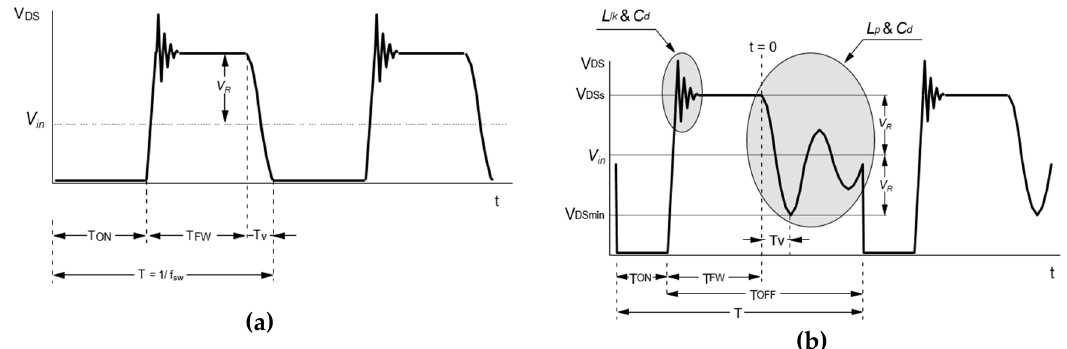
Figure 6. Drain to source voltage waveforms for a DCM flyback ( a ), and a QR flyback ( b ). A simplified schematic of a QR flyback LED driver (not for Hi-PF applications) is shown in